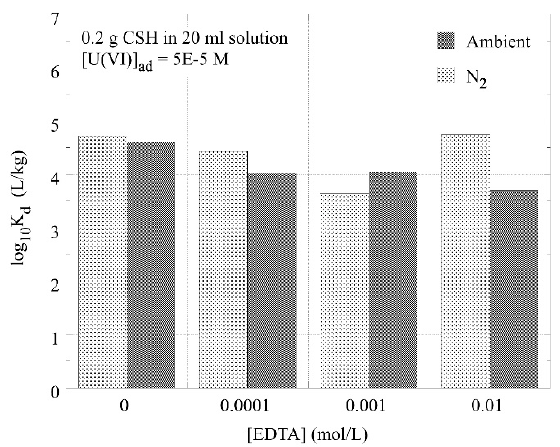
Figure 8. The log 10 K d values calculated for the U(VI) sorption by C-S-H under ambient and N 2 at- mosphere.